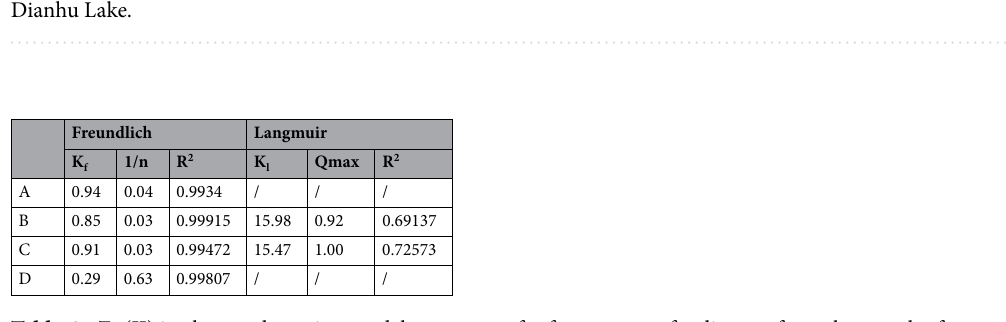
Table 6. Zn(II) isotherm adsorption model parameters for four groups of sediments from the mouth of Dianhu